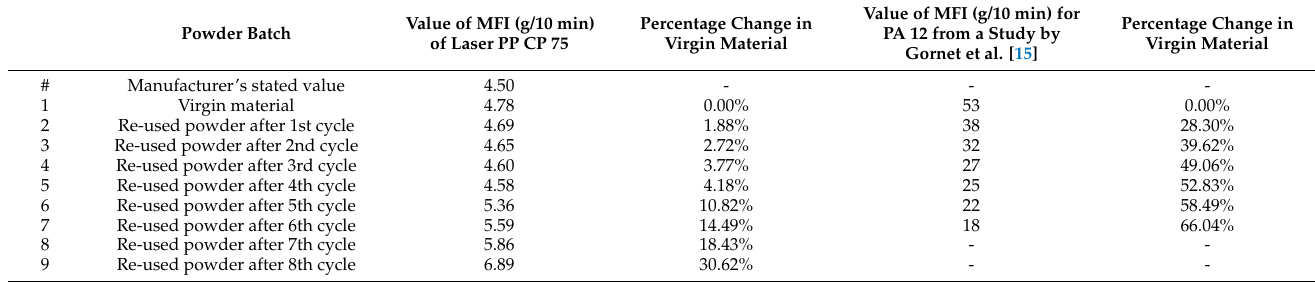
Table 4. MFI values for the nine batches of powder considered in the analysis.